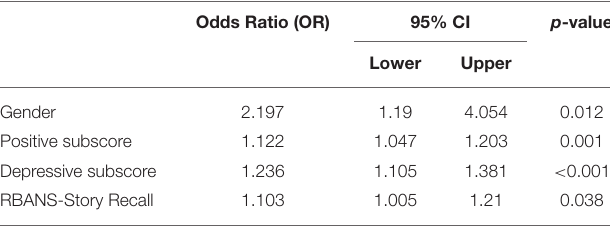
TABLE 3 | Factors for suicide attempts in middle-aged and elderly schizophrenia